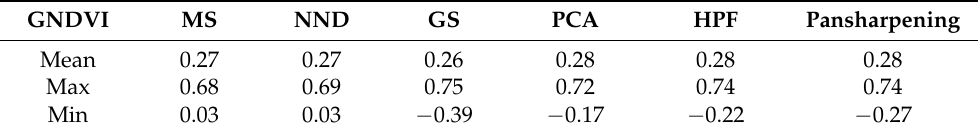
Table 3. Comparison of GNDVI statistical results of different fusion images. GNDVI MS NND GS PCA HPF Pansharpening Mean 0.27 0.27 0.26